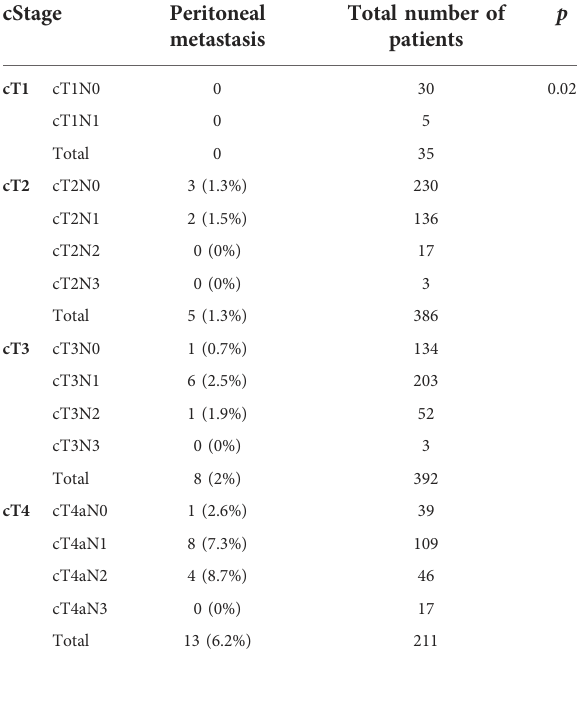
TABLE 5 Frequency of peritoneal metastasis according to the clinical stage.